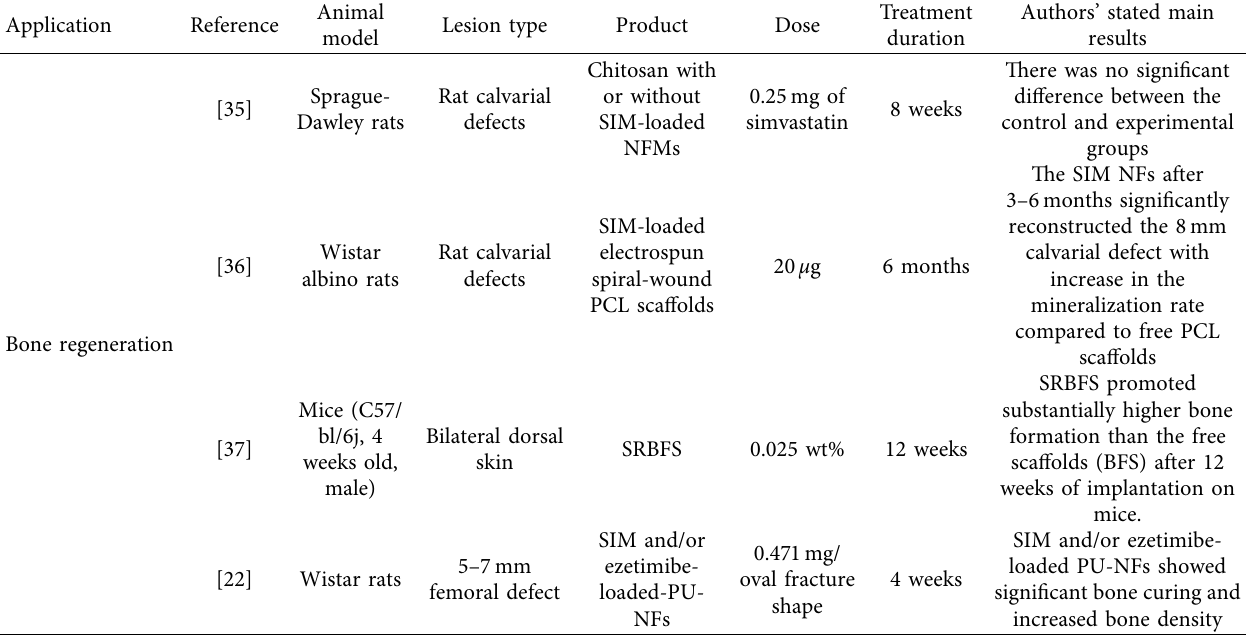
Table 2: Summary of in vivo application of statins in various studies.